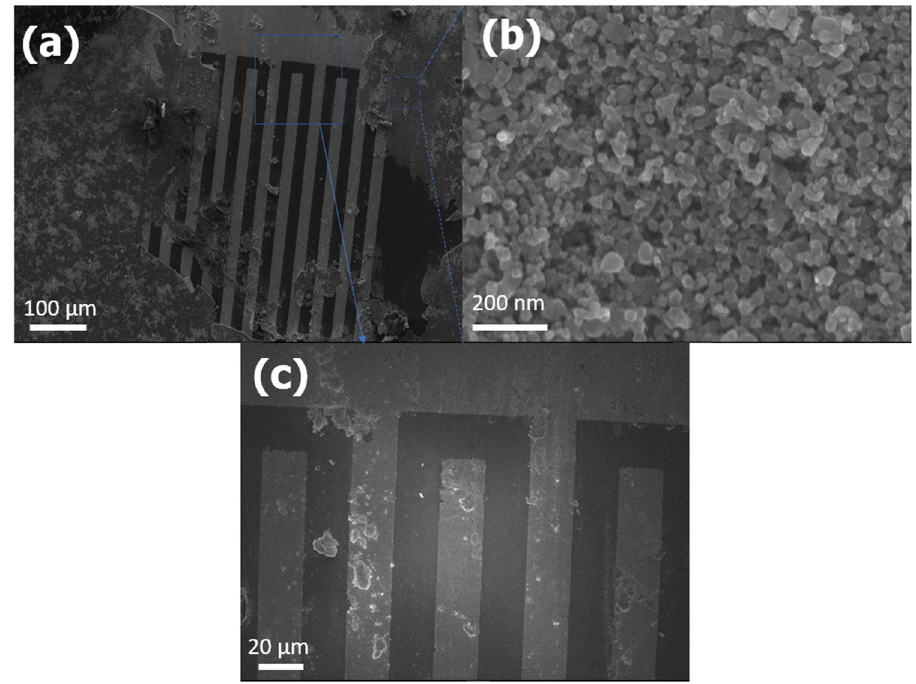
Figure A1: ( a – c ) The SEM images of patterned Pt electrode - coated mp - TiO 2 .